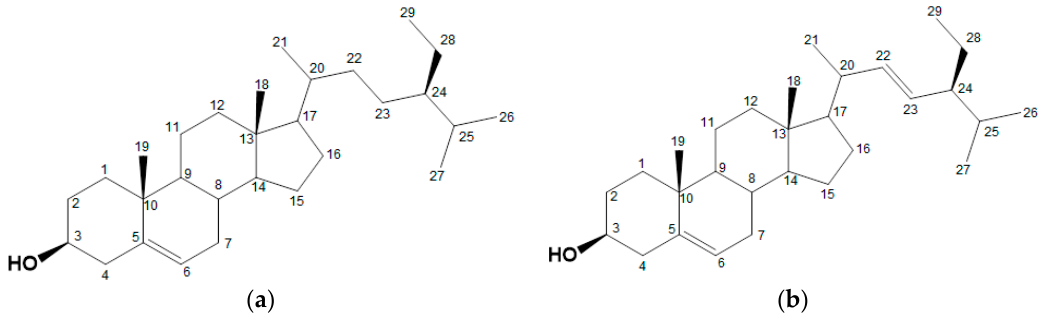
Figure 2. Structure of ( a ) β -sitosterol and ( b ) stigmasterol.